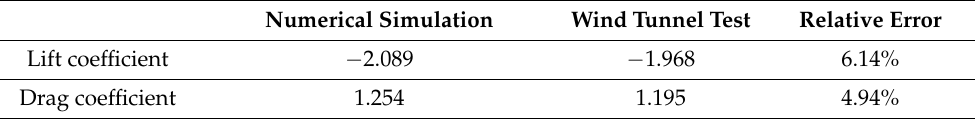
Table 2. Comparison of lift coefficient and drag coefficient between numerical simulation and wind tunnel test.